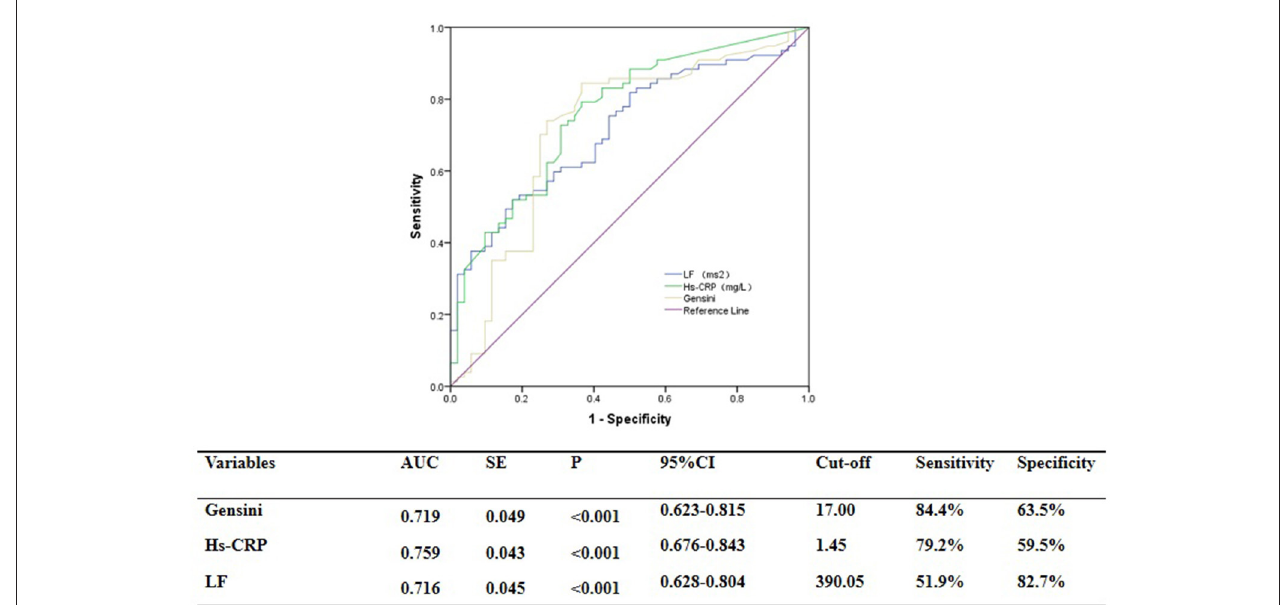
FIGURE 5 | ROC analysis for the predictive efficacy of variables for functional ischemia of target vessel as detected by cQFR.